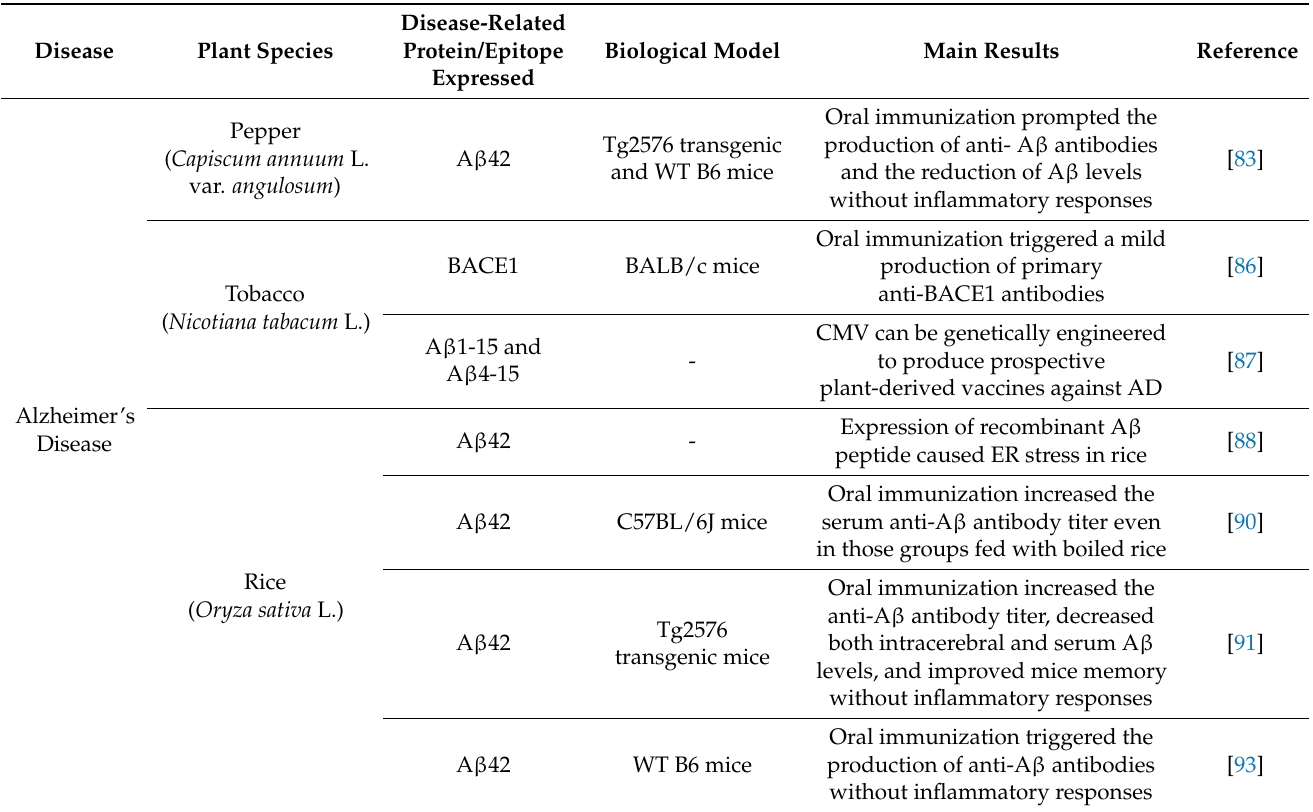
Table 1. Principal findings achieved with plant-based vaccines targeting different